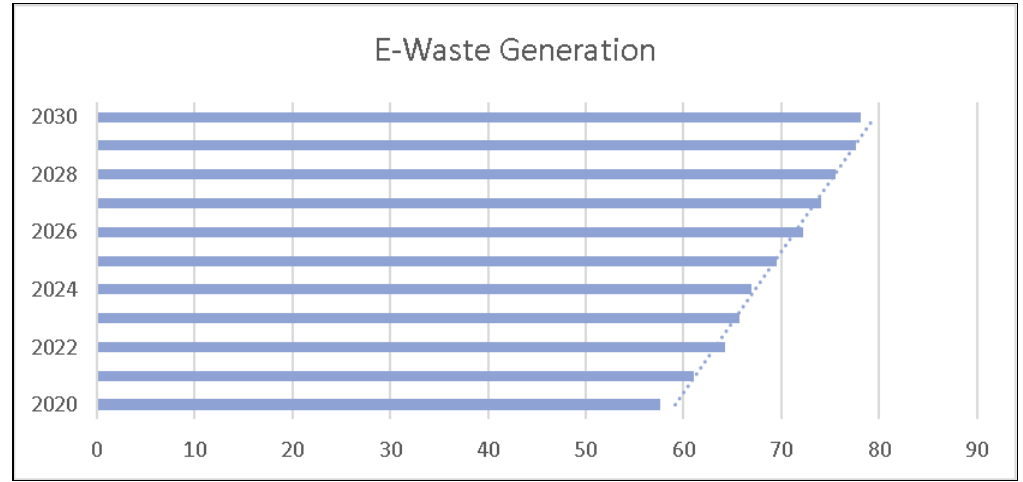
Figure.6. Yearly Increases in E-Waste Source: (Herat & Agamuthu,